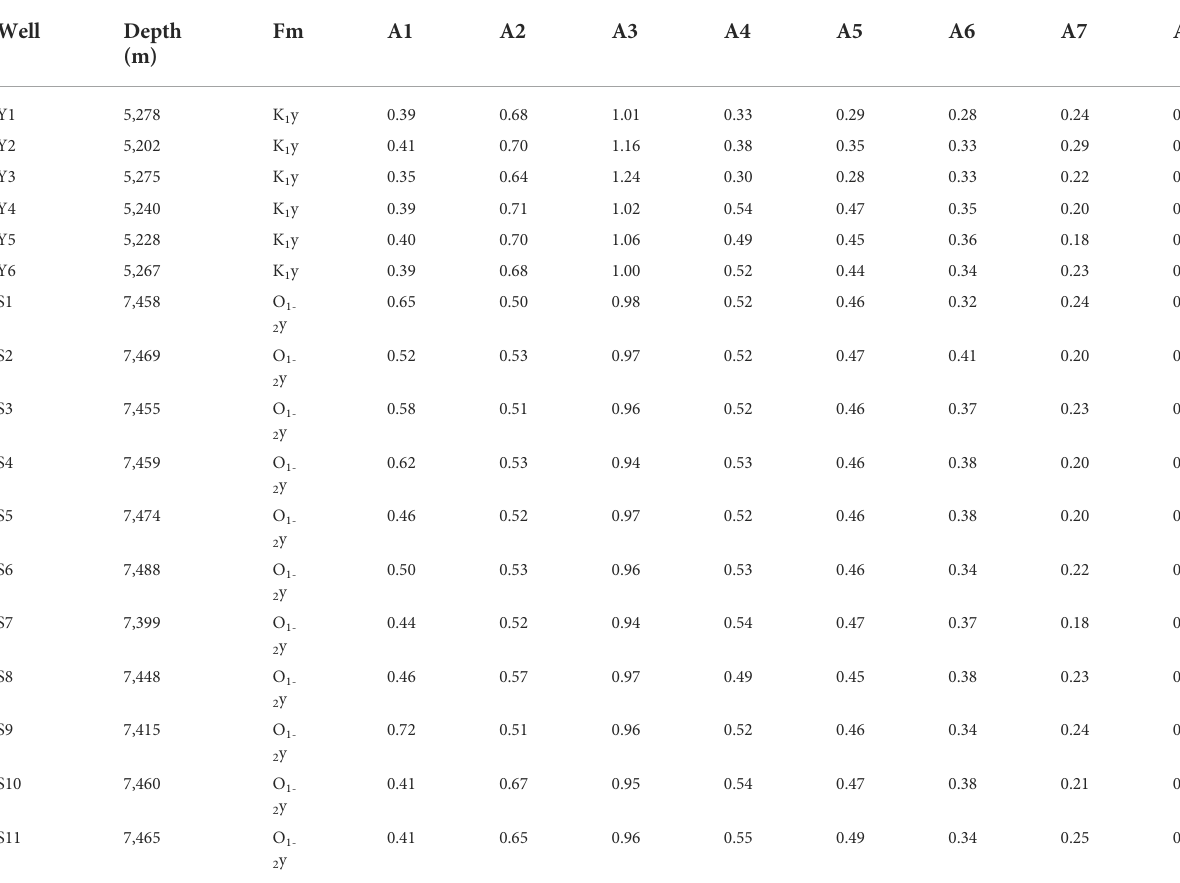
TABLE 1 Organic molecular parameters of oil samples from Yakela Field and Shunbei Field. Well Depth